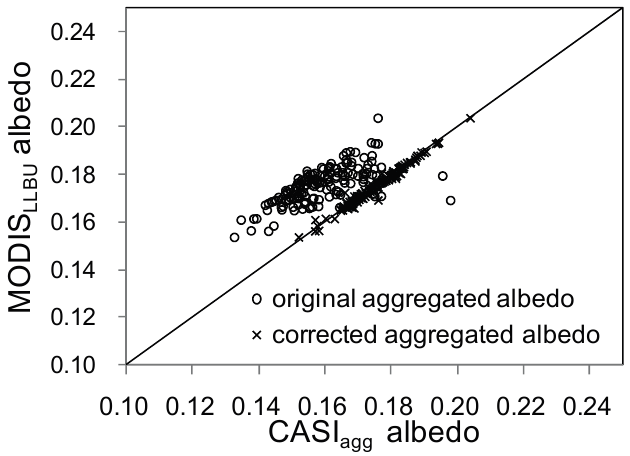
Figure 17. Scatterplots of the MODIS LLBU and CASI agg albedos, where circles represent the results from the CASI agg_ori and MODIS LLBU images, and crosses represent those from the CASI agg_cor and MODIS LLBU images.